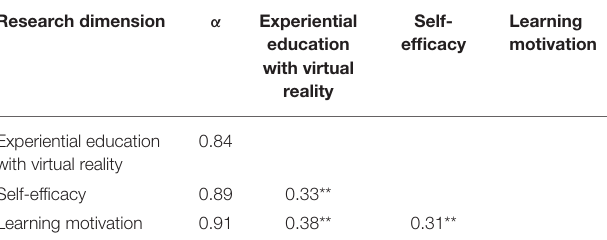
TABLE 1 | Correlation